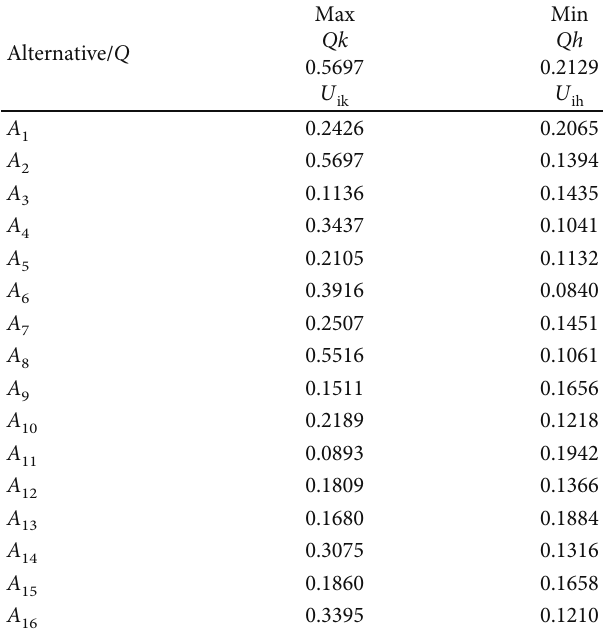
Table 6: Magnitude of optimal alternative and alternatives.